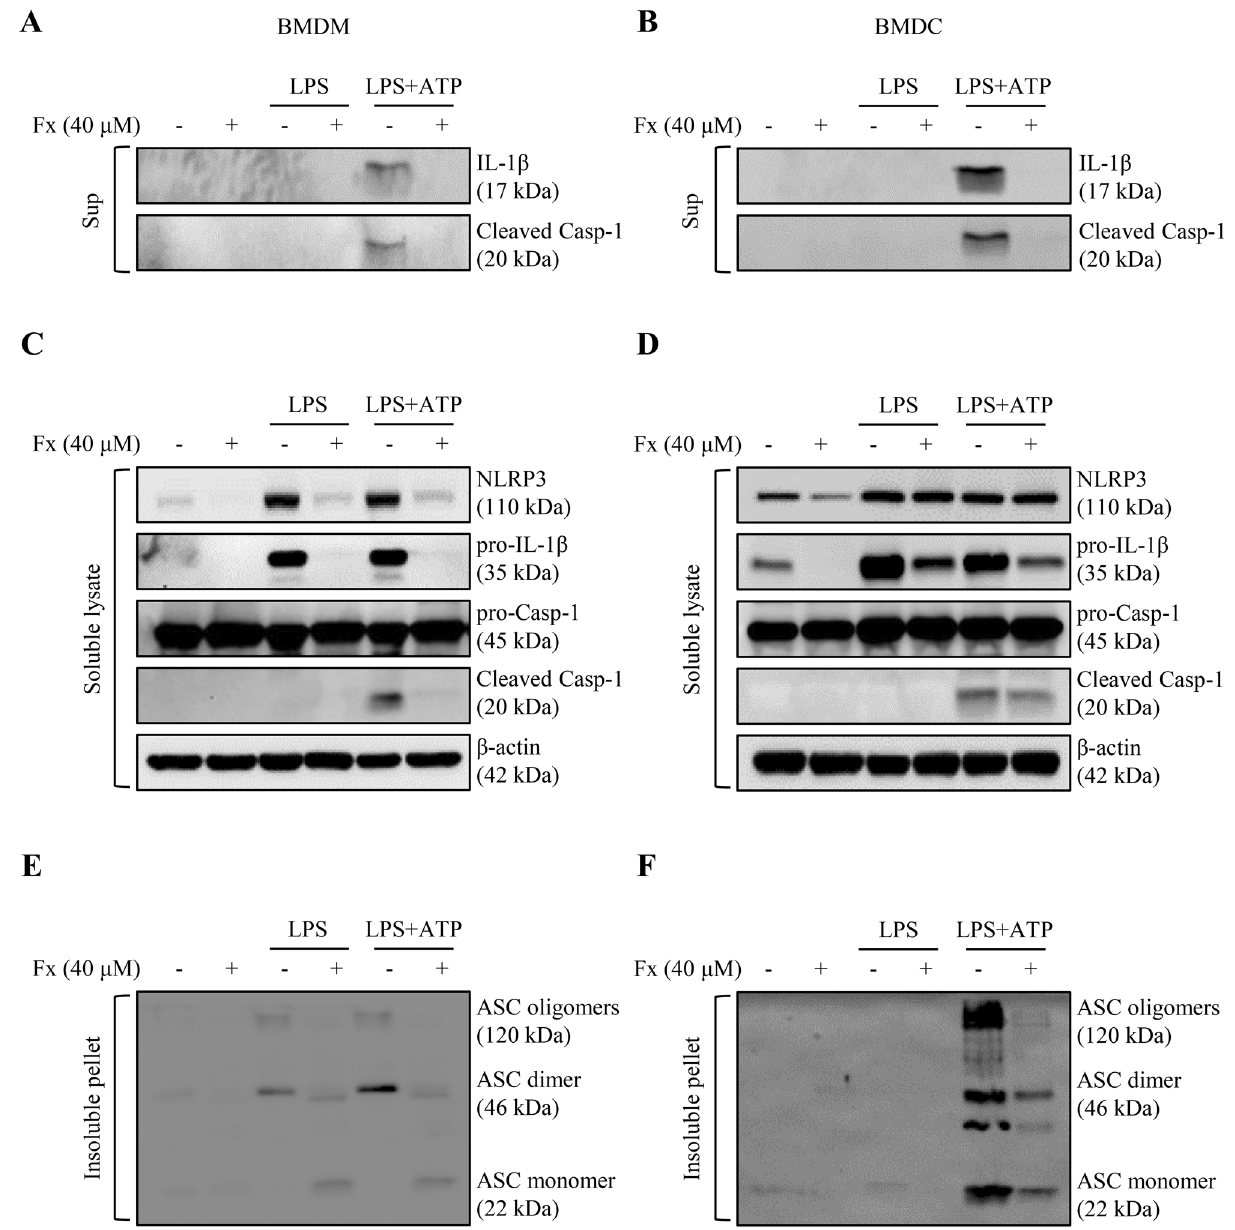
Figure 4. Western blot analysis of NLRP3 inflammasome activation in bone marrow-derived macrophages (BMDMs) and dendritic cells (BMDCs). Both types of cells were treated with LPS (1 μg/ml) and ATP (5 μM), and the changes with or without fucoxanthin (40 μM) pre-treatment 4 h ago were compared. ( A , B ) Expression levels of the mature form of IL-1β and proteolytically processed caspase-1 in the culture media of BMDMs ( A ) and BMDCs ( B ). ( C , D ) Western blot analysis of NLRP3 inflammasome component expression in LPS/ATP treated BMDMs ( C ) and BMDCs ( D ) with or without fucoxanthin. ( E , F ) ASC oligomerization in cross-linked pellet of BMDMs ( E ) and BMDCs ( F ) was also analyzed by chromatogram was obtained at 450 nm and a standard compound of all- trans -fucoxanthin was used to construct a calibration curve in a range from 1 to 200 μg/ml for quantitative analysis as previously described 21 . Preparation of bone marrow‑derived macrophages (BMDMs) and dendritic cells (BMDCs). For the primary culture of BMDMs, the femur was isolated from 6–8-week-old mice. Femoral bone marrow cells were cultured at a density of 5 × 10 6 cells with DMEM medium (Gibco) supplemented with 20% fetal bovine serum (Gibco), 30% L929 cell-conditioned medium, 50 μM 2-mercaptoethanol (Daejung), 100 units/ml peni- cillin, and 100 μg/ml streptomycin (Gibco) in a 100 mm bacteria dish. After a full day, nonadherent cells were collected and resuspended in a fresh medium. Aliquots of 1 × 10 6 cells were cultured for 10 days at 37 °C and 5% CO 2 in a 100 mm cell culture dish. Fresh culture medium was added on day 4 and replaced on day 7 38 .